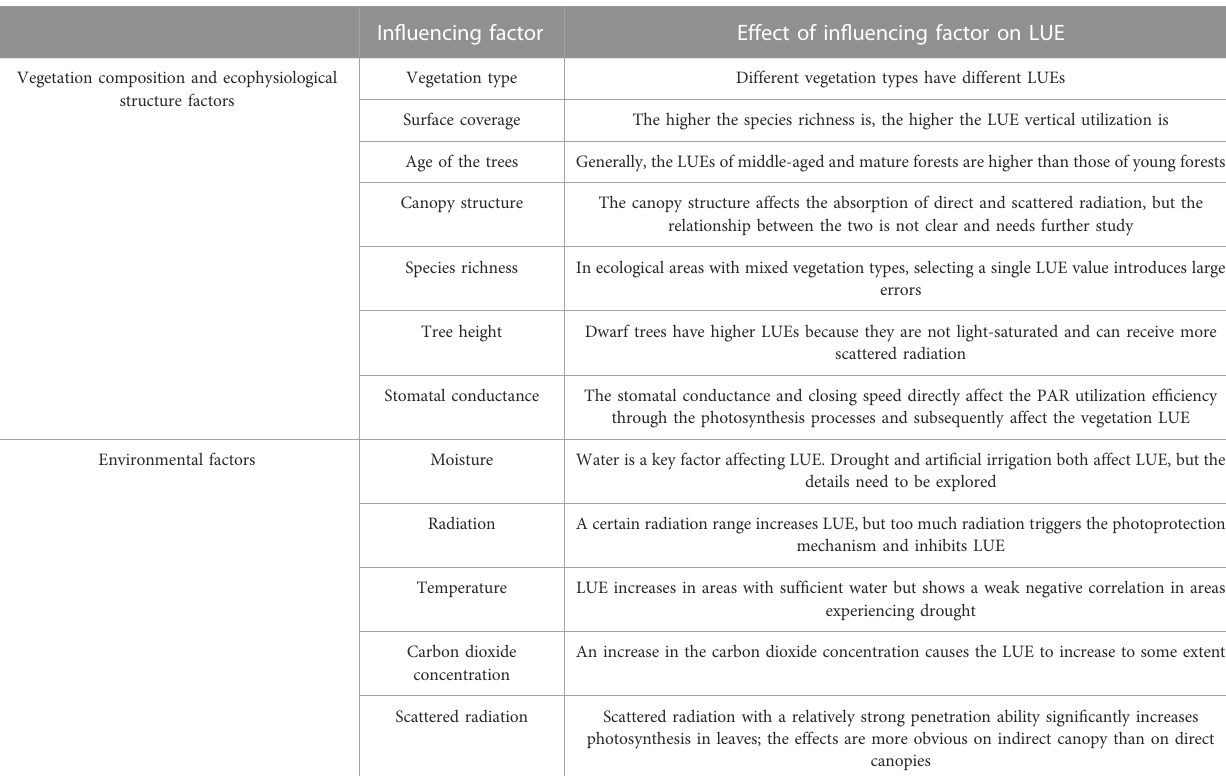
TABLE 2 In fl uencing factors of